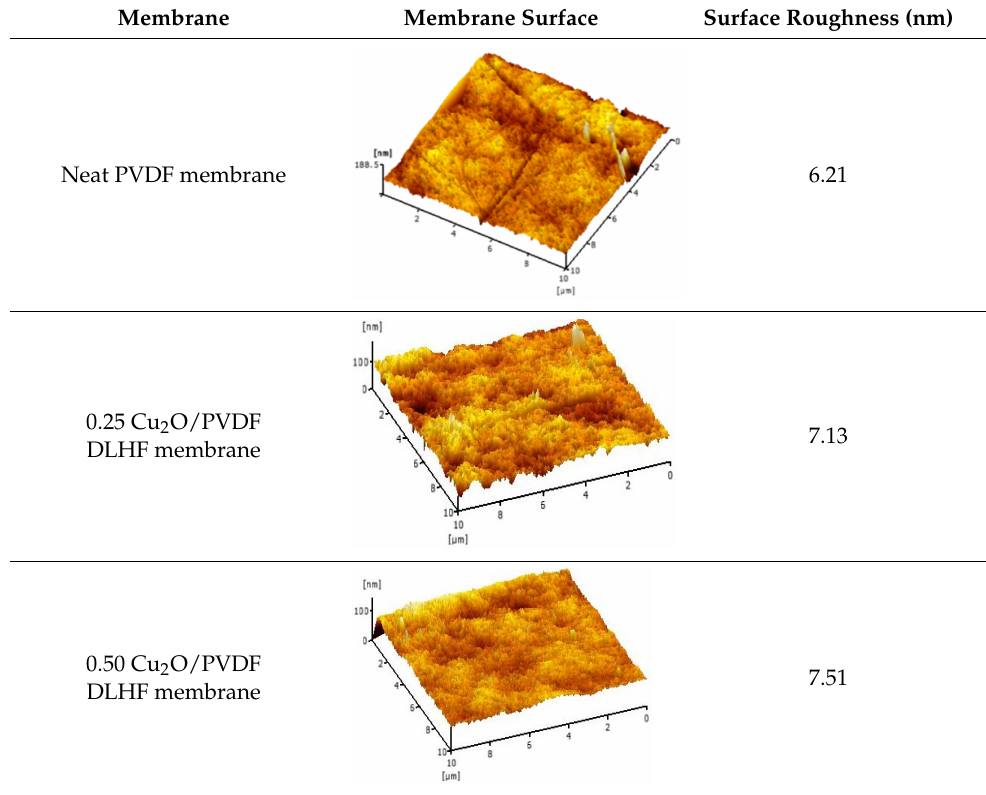
Table 4. AFM analysis of neat PVDF membrane and Cu 2 O/PVDF DLHF